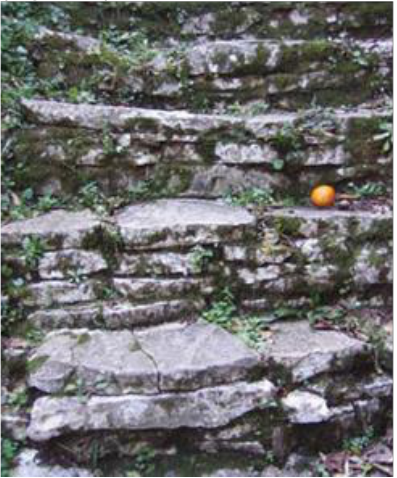
Figure 4. Pathways- stairs in stone